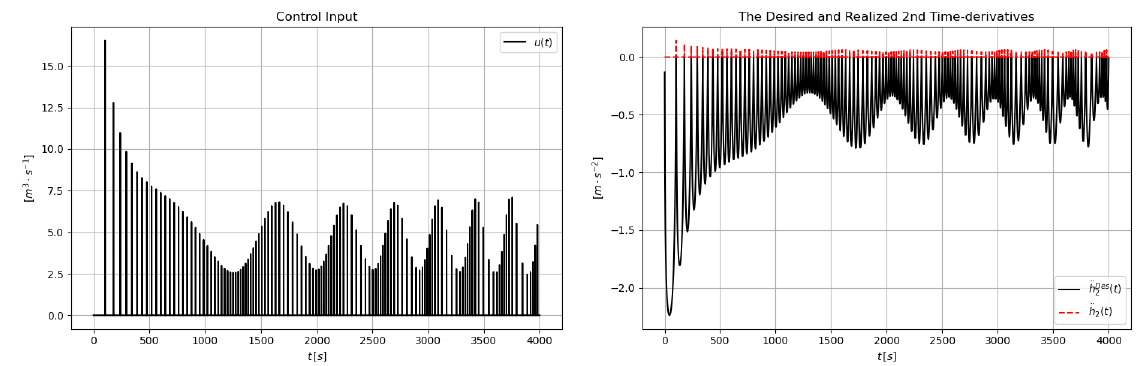
Figure 6. The Control input and second time-derivatives without adaptivity.